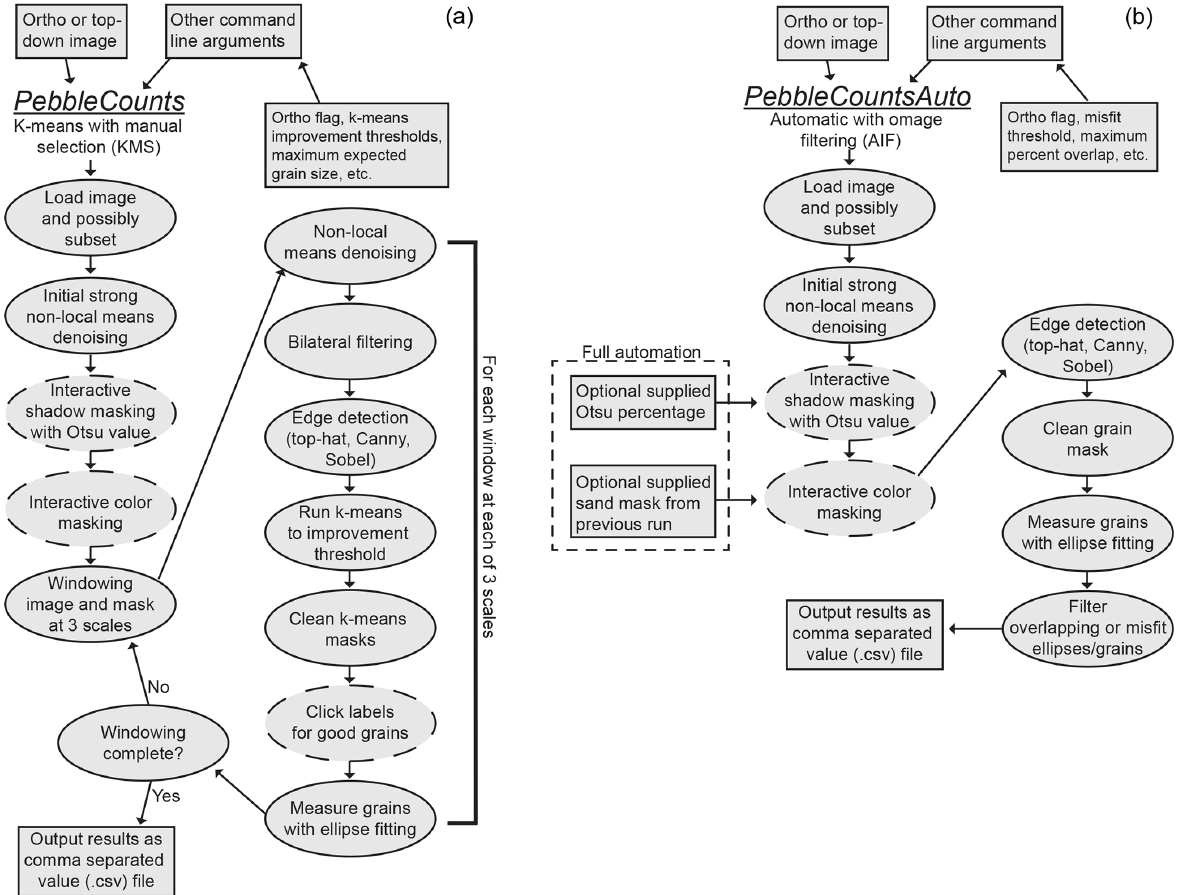
Figure 3. Flowchart of PebbleCounts (a) and PebbleCountsAuto (b) . The boxes are user-supplied input or output from the algorithm. Dashed lines indicate a user input step during processing, either entering and checking values or